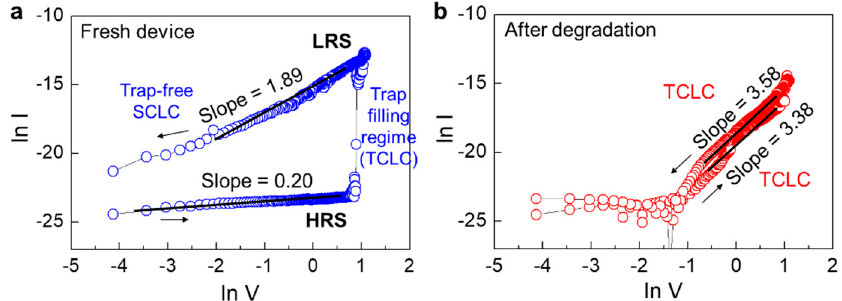
Figure 5. ( a ) Current-voltage (I-V) curves of the CdSe/ZnS QD-PMMA memristor, ( a ) fresh device, and ( b ) after degradation.